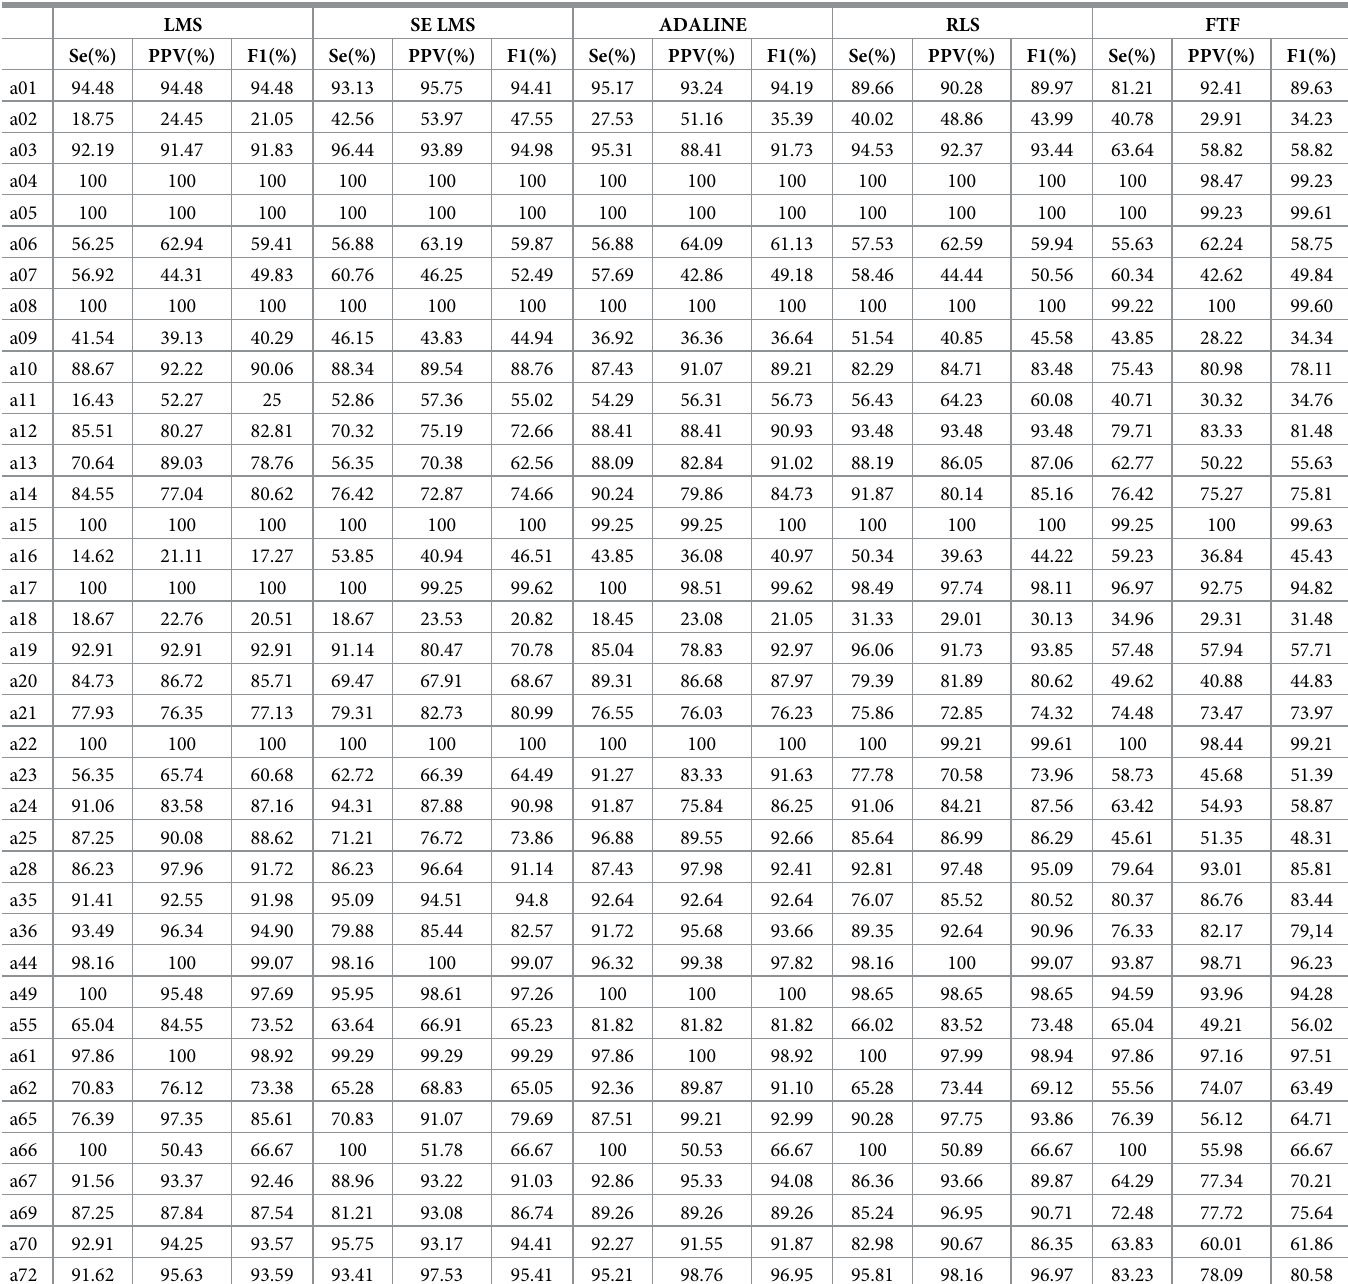
Table 4. Results of the experiments on dataset B from the challenge 2013